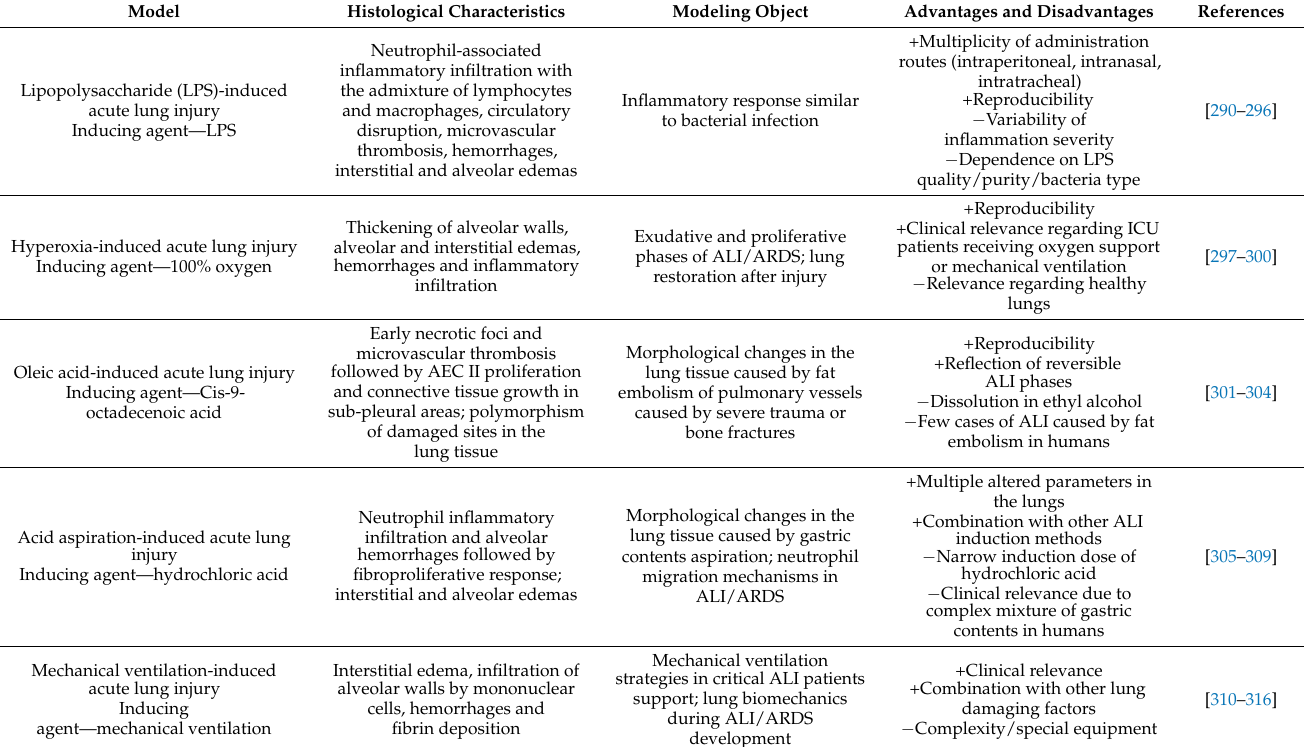
Table 1. Overview of acute lung injury murine